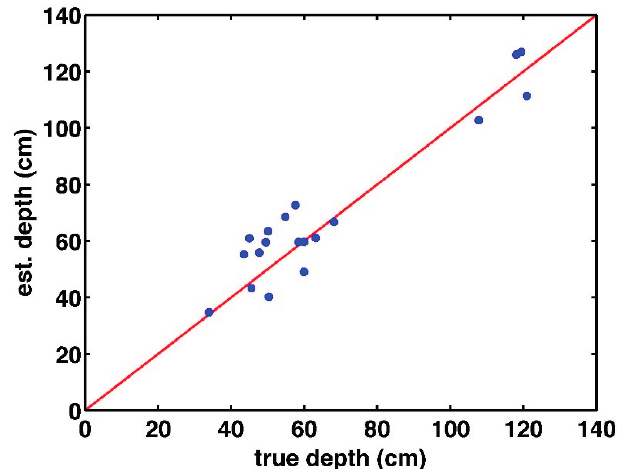
Figure 7. Scatter plot of observed snow depth vs. estimated snow depth calculated from conventional BA techniques and GCPs ( n = 20). The RMSE was 9.59 cm. The R 2 value was